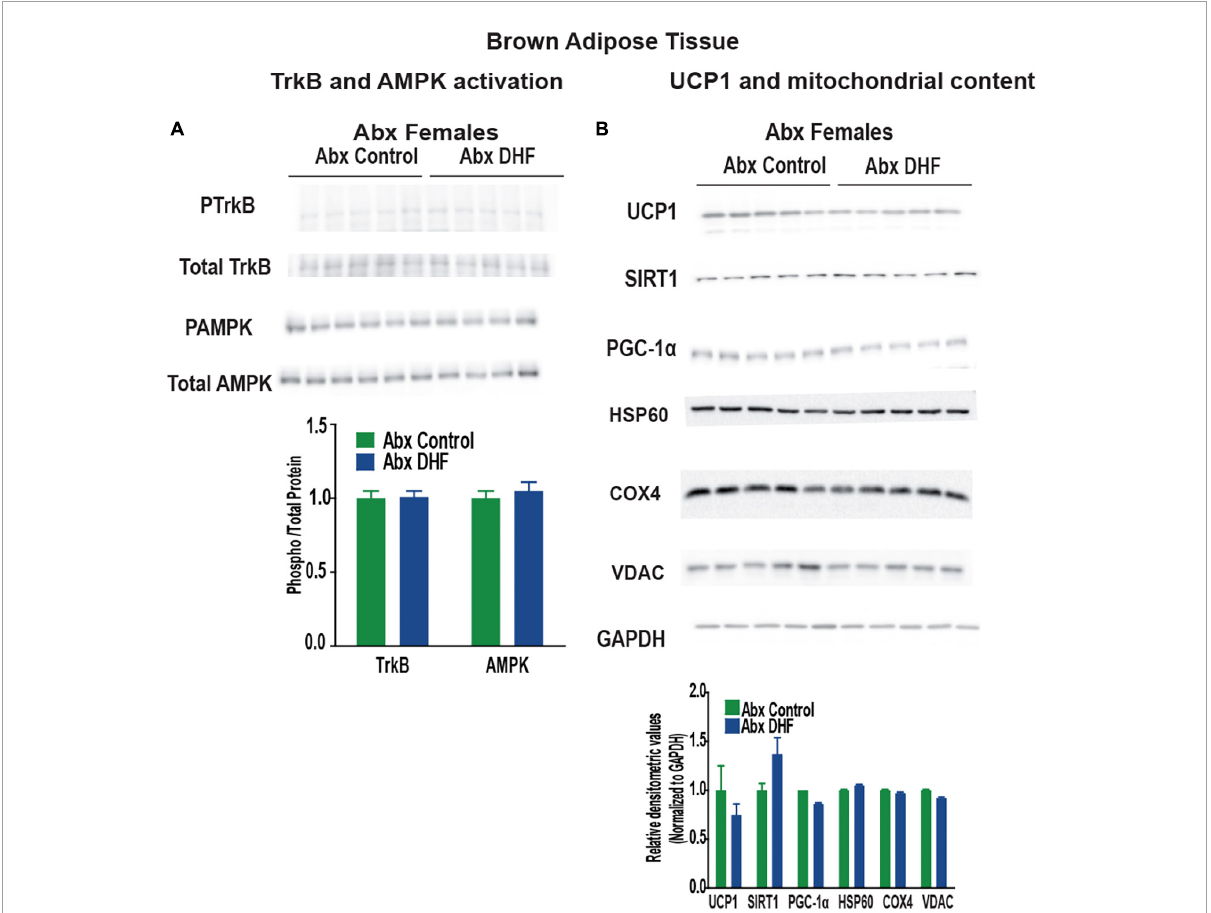
FIGURE6 Gut microbiome ablation prevents induction of UCP1 and TrkB activation by DHF in BAT of females. (A) Expression and quantification of TrkB and AMPK activation in BAT. (B) Expression and quantification of mitochondrial content markers in brown adipose tissue (BAT). Statistical analyses were carried out using student’s t -test. p -values < 0.05 were considered significant. Data are expressed as average ± SEM ( n =